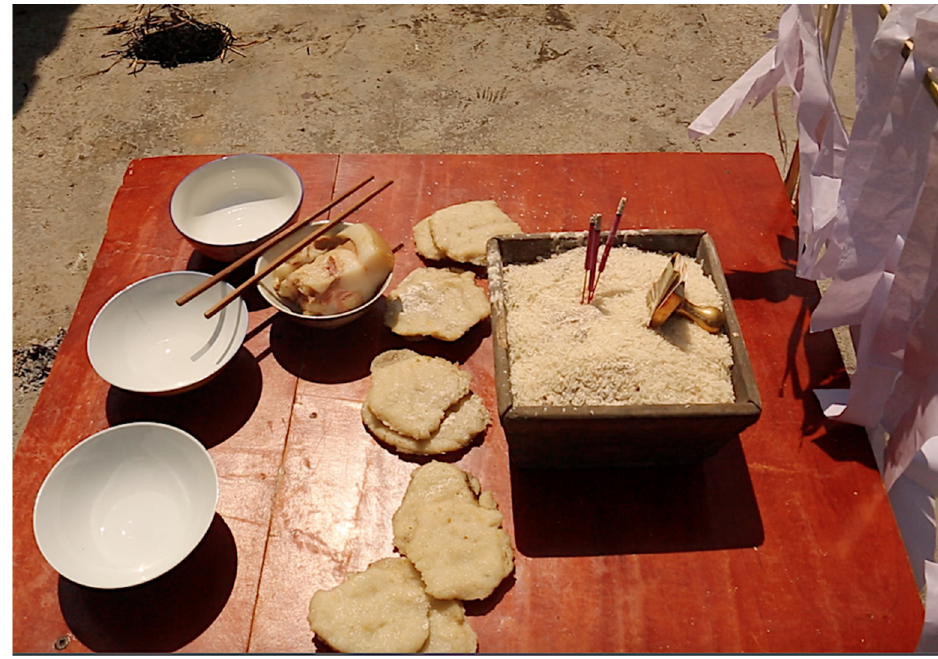
Figure 9. The table altar setting for the first phase of the tali tree ritual. (Photo: Thomas Riccio).